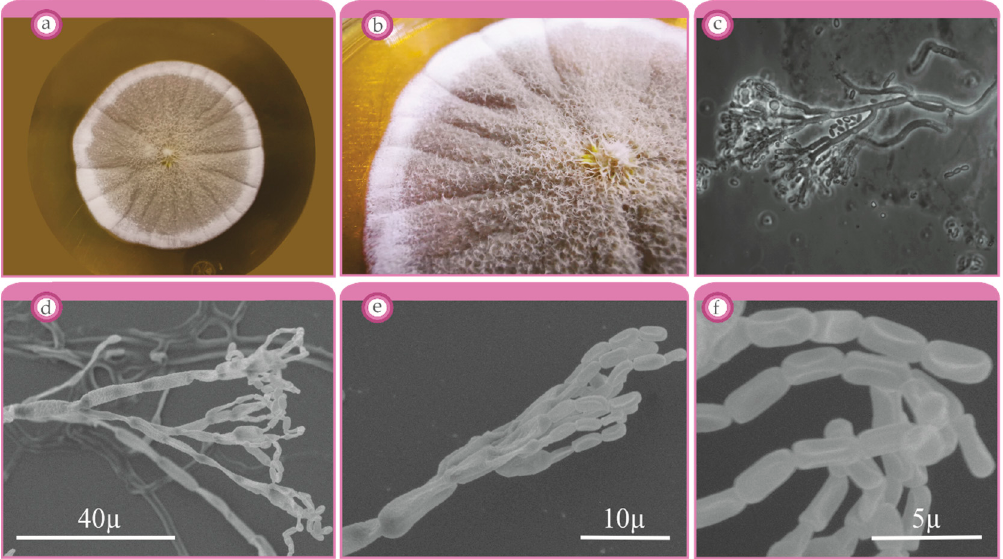
Figure 6. Colonies and microscopy characteristics of the strains obtained from J. flaccida - P. deleoni and clustered with G. langdonii-Geosmithia sp. 32 clade. ( a , b ) Colonial morphology in MEA; ( c ) conidia at 14 days of incubation in MEA using blue cotton in phases microscopy (40X); ( d – f ) electronic microscopy of penicilli and